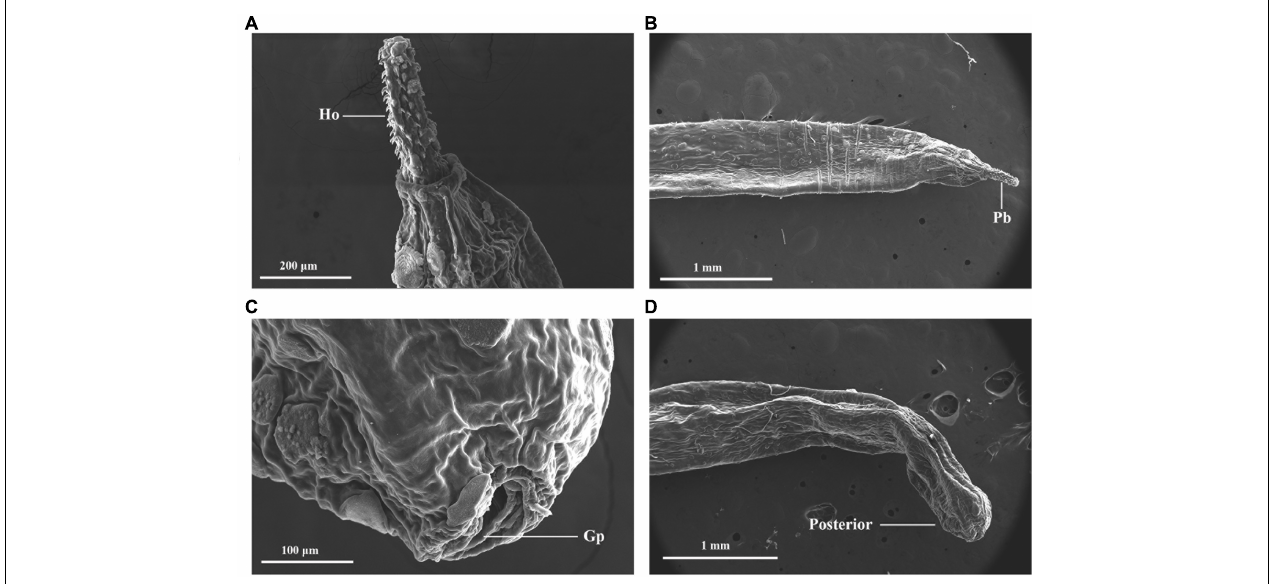
FIGURE 2 | External morphology of Moniliformis sp. XH-2020 via SEM: (A) anterior end of the adult with proboscis; (B) lateral view of the proboscis with hooks, (C) posterior end of the adult, (D) posterior end showing a terminal gonopore. Pb, proboscis; Ho, hook; Gp, gonopore.